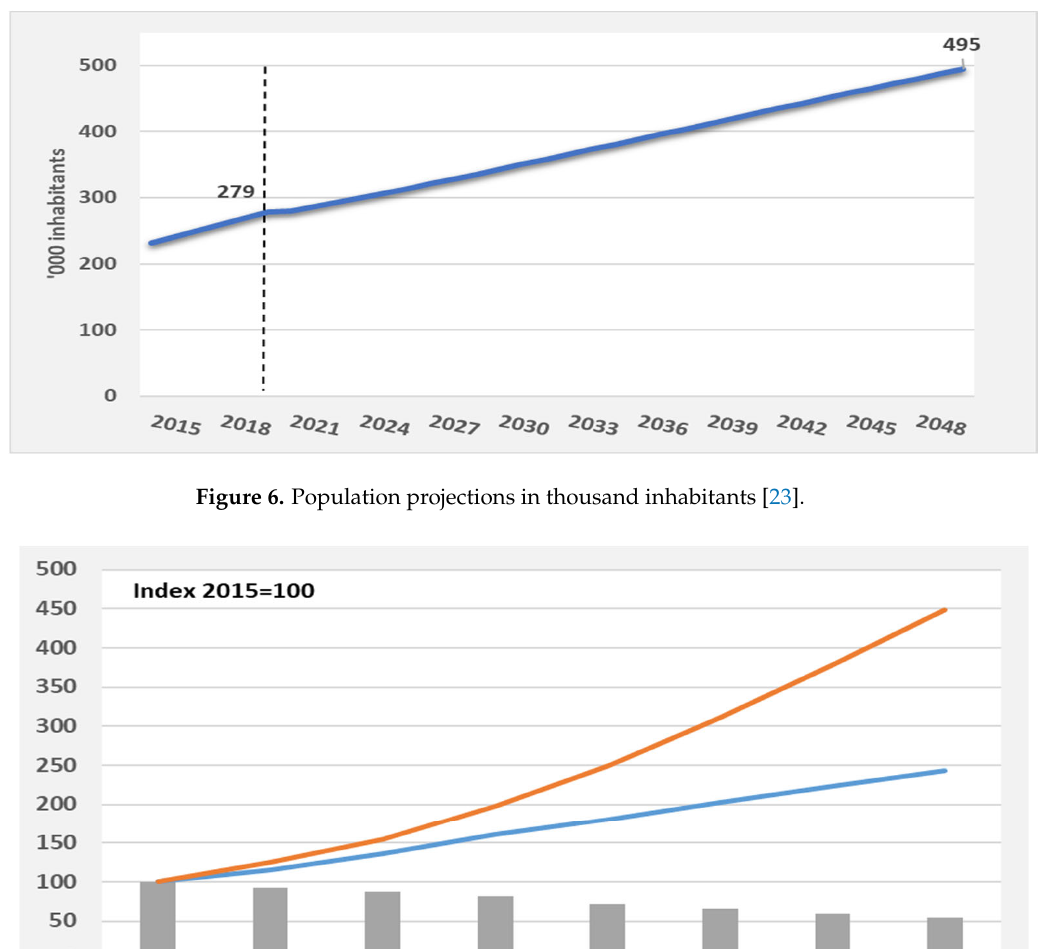
Figure 6. Population projections in thousand inhabitants [22].